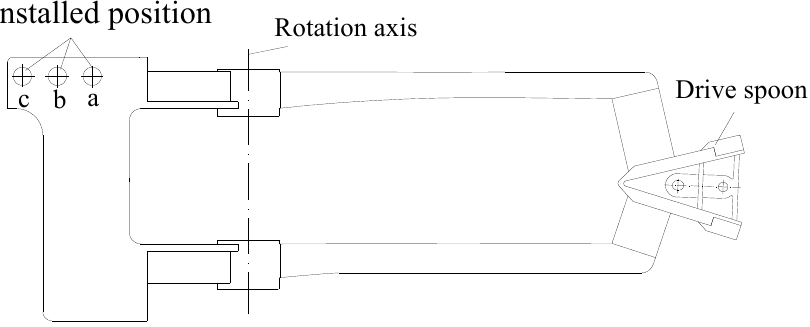
Figure 1. Schematic diagram of the drive arm.